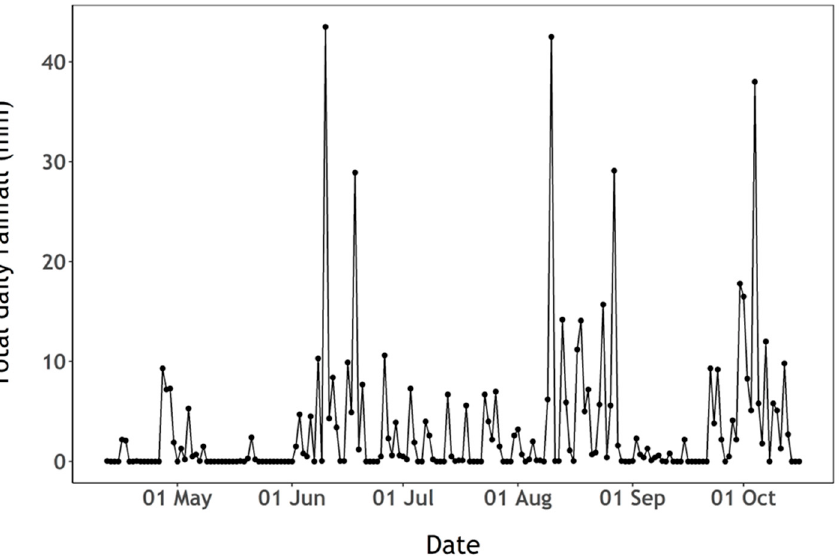
Figure 5. Total daily rainfall (mm) observed at the Virginstow, Beaworthy weather station.